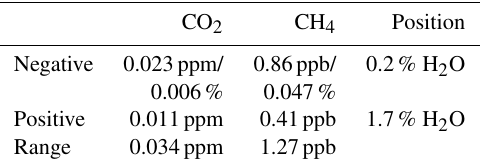
Table 6. Maximum differences between dry air mole fractions based on the standard and expanded water correction models from the experiment with Picarro no. 3. The largest differences are also given as percentages of the mole fractions measured in dry